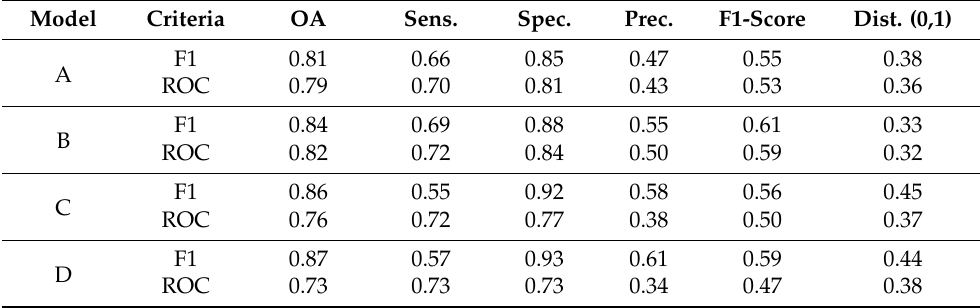
Table 8. Results of the AdaBoost models with the best parametric configuration for each variable combination. Criteria for the selection of the best model are maximum F1-score (F1), minimum distance to the optimal point (0,1) in the ROC curve (ROC) or both (F1/ROC). All the metrics are computed from the validation set. AdaBoost variant is also shown. (OA: Overall accuracy; Sens.: sensitivity; Spec.: specificity; Prec.: precision; Dist. (0,1): distance to the point (0,1) in ROC curve).